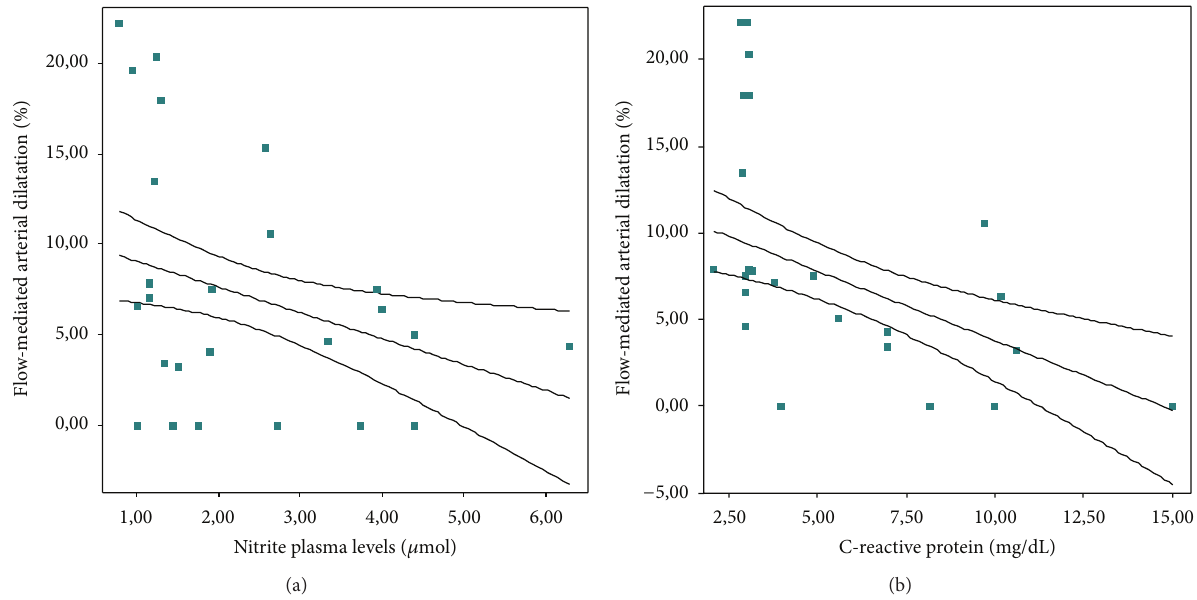
Figure3:Relationshipofflow-mediatedarterialdilatation(FMAD)withnitriteplasmalevelsandC-reactiveprotein(hsCRP)levels.(a)Trend towards a negative correlation between FMAD and nitrite plasma levels ( 𝑟 = −0.24, 𝑃 = 0.07 ). (b) Negative correlation between FMAD and hsCRP ( 𝑟 = −0.63, 𝑃 < 0.01